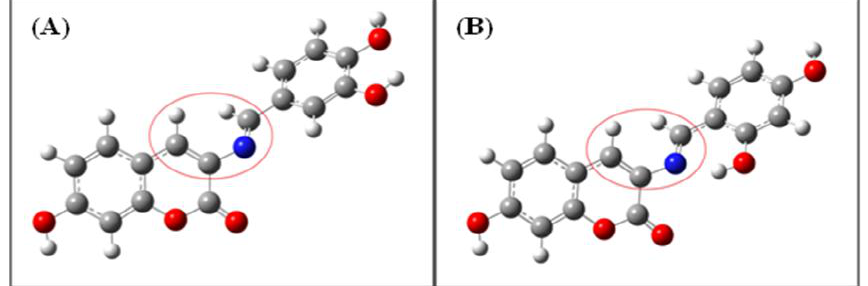
Figure 7. Calculated structures for ( A ) BS1 and ( B ) BS2 . Atoms forming dihedral angles are shown in red